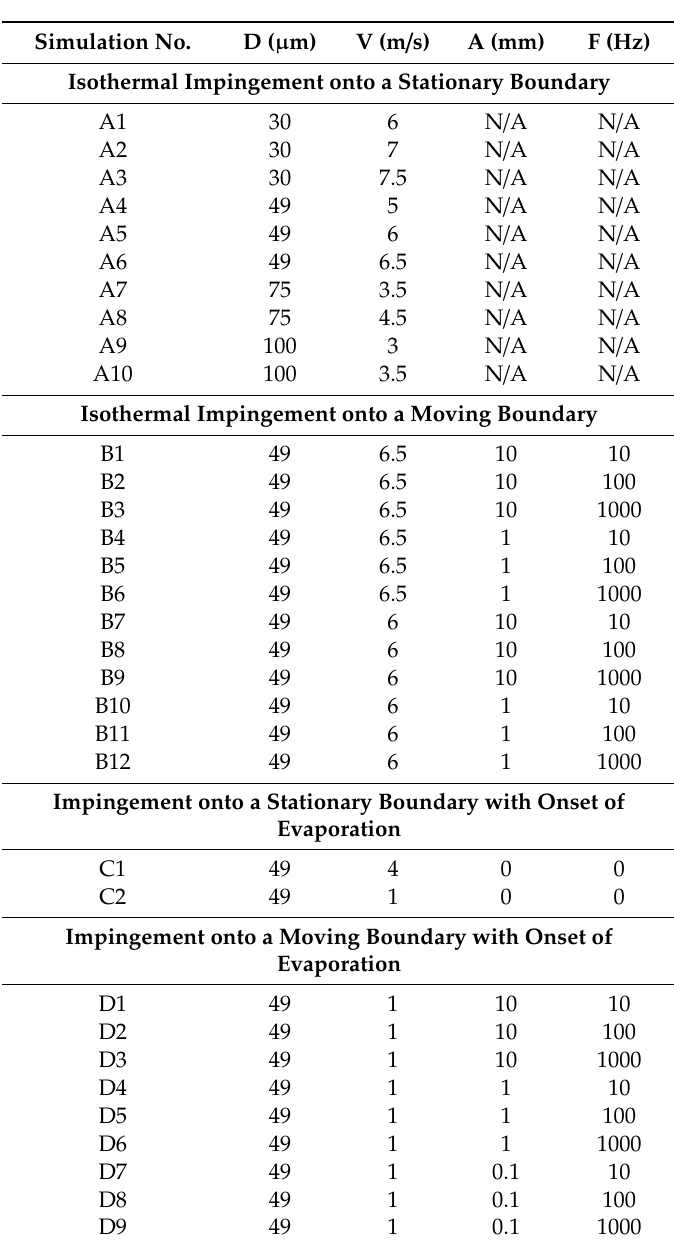
Table 2. Droplet parameters and boundary frequencies and amplitudes used in the simulations. N / A, not